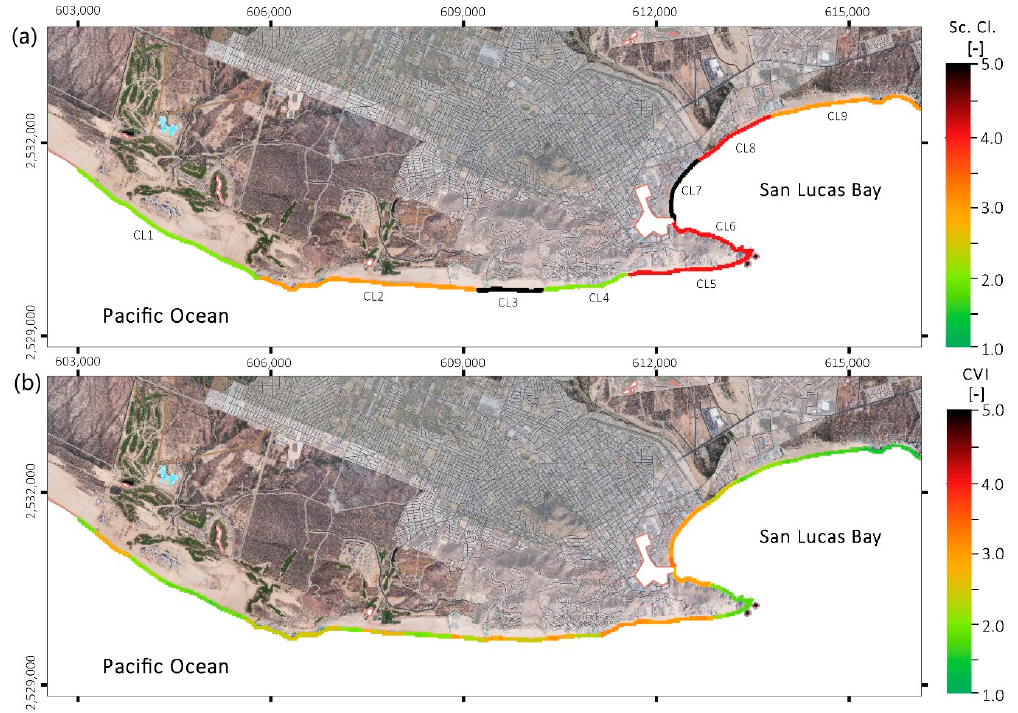
features are less attractive than those of other sites, the built environment here integrates smoothly into the cliffs. This built environment dates from 1975 and was designed not to Figure 7. Human and natural scores given for the coastal landscapes (CL) assessed in the study Figure 7. Human and natural scores given for the coastal landscapes (CL) assessed in the study area. affect the landscape. area.